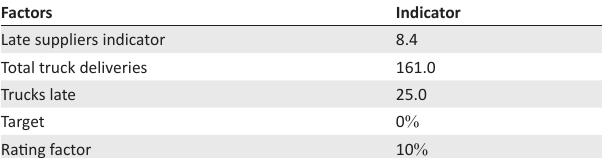
TABLE 4: Late supplier deliveries.